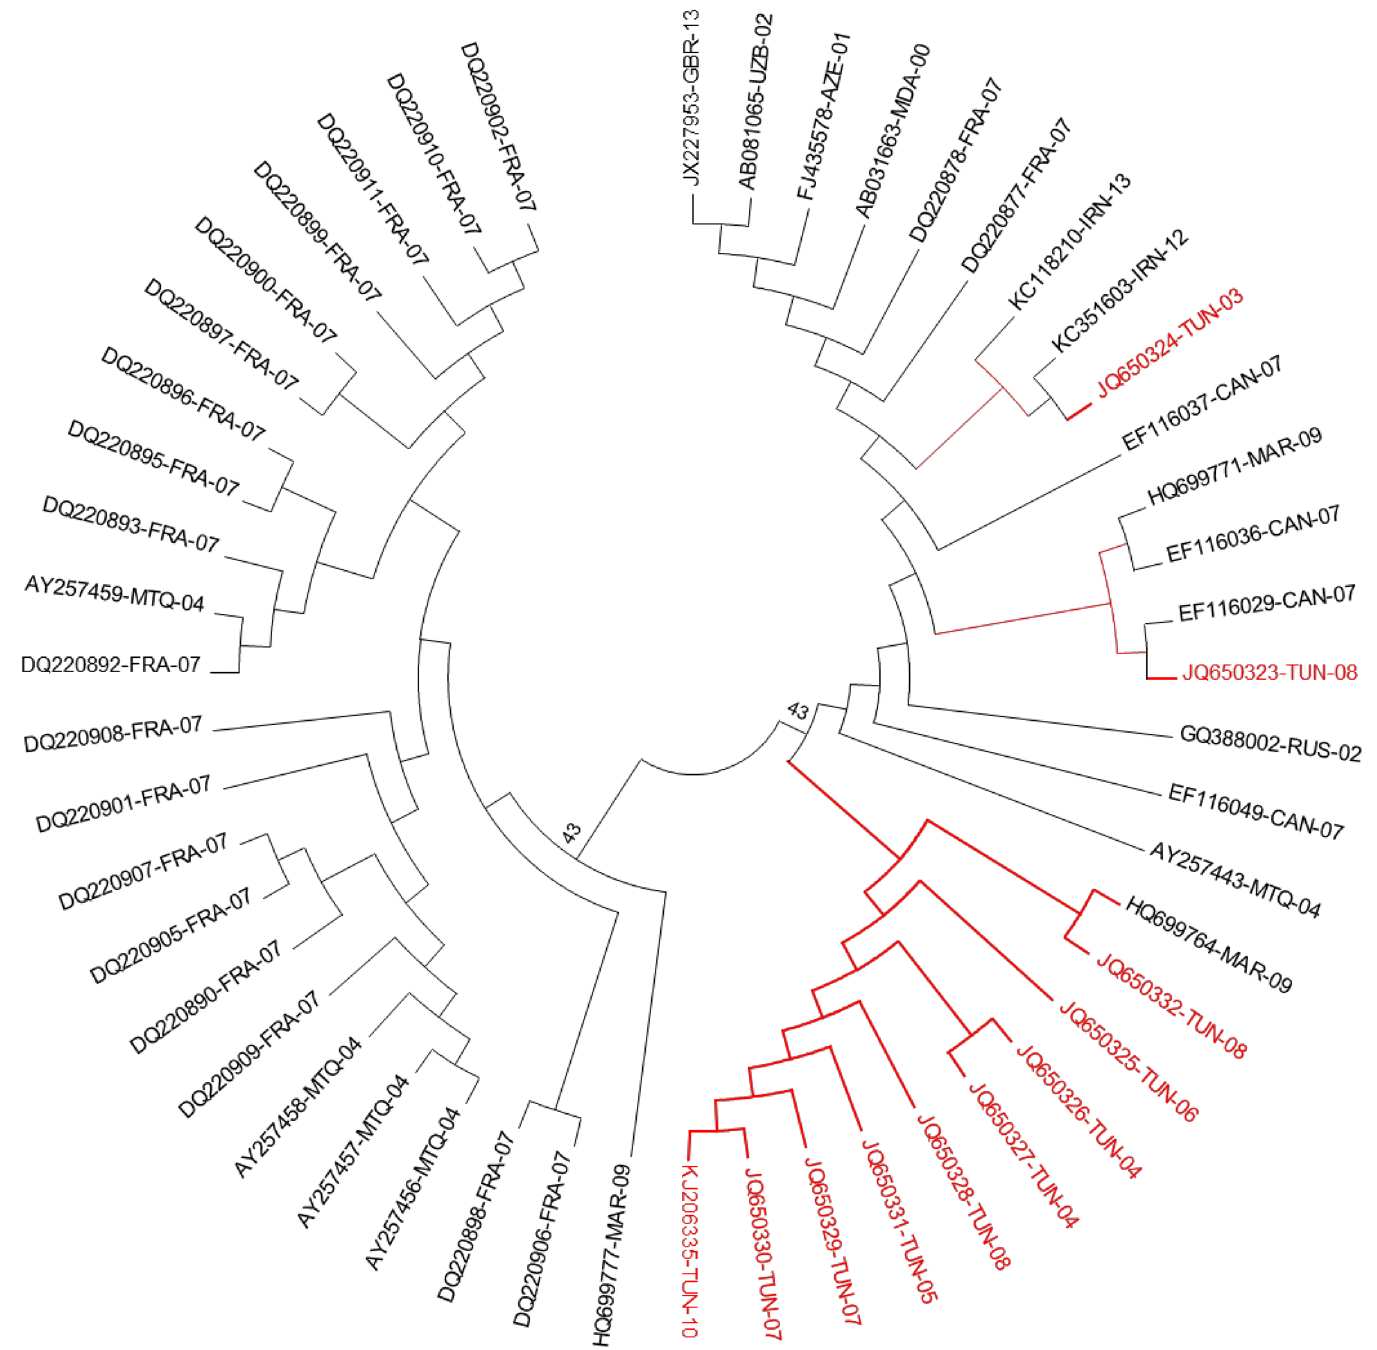
Fig 2. Phylogenetic analysis of isolates from Subtype 2k. Phylogenetic analyses were performed using the Maximum Composite Likelihood method included in the MEGA package (version 5.1). The reliability of the phylogenetic constructions was estimated by bootstrap analysis with 1000 pseudo replicate data sets. The tree is based on the analysis of a 222-nucleotide long fragment in the NS5B region (nucleotides 8346 to 8568 according to the H77-1a prototype strain, AF009606). It includes the 11 studied Tunisian sequences (in red) and 39 HCV-2k field sequences from other countries (in black). All the sequences were indicated by their Accession Numbers followed by the country code and the collection date. The country codes according to the standard abbreviation are: France (FRA), Martinique (MTQ), Canada (CAN), Russia (RUS), United Kingdom (GBR), Uzbekistan (UZB), Azerbaijan (AZE), Morocco (MAR), Iran (IRN) and Moldova (MDA).